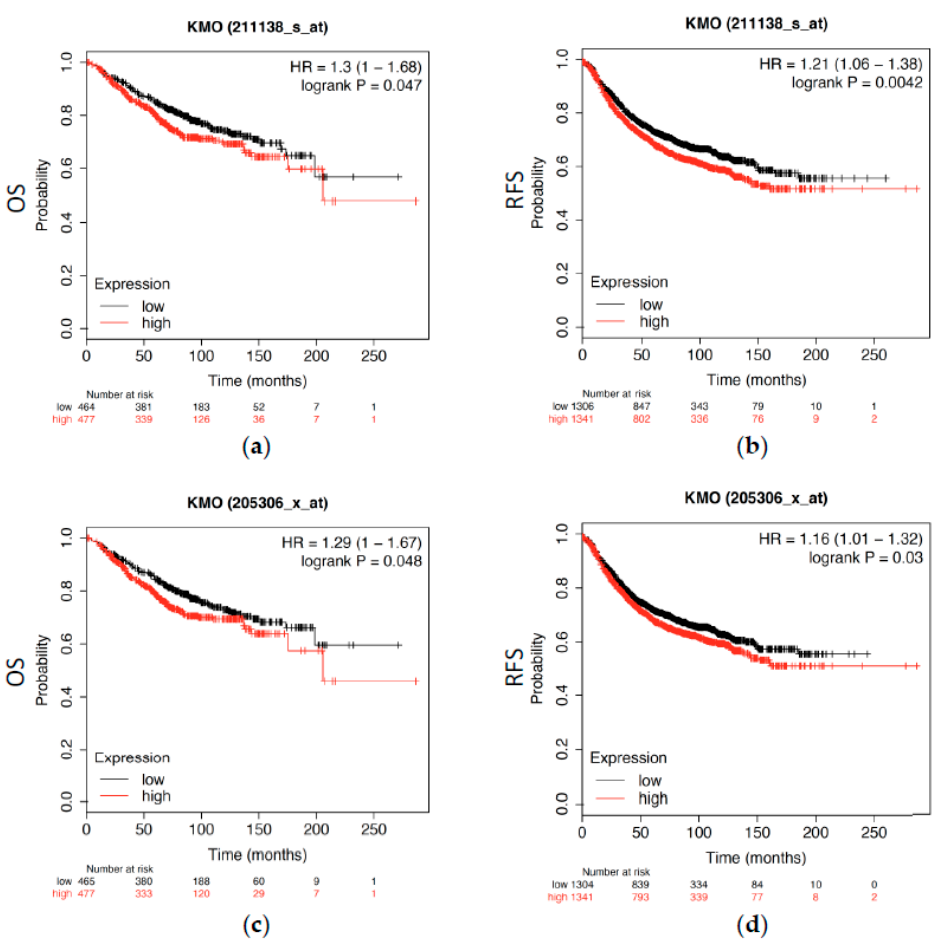
Figure 4. The prognostic value of KMO mRNA levels in breast cancer patients using the Kaplan– Meier plotter. Association between KMO ( a , b ) 211138_s_at and ( c , d ) 205306_x_at expression, and the OS and RFS rates in patients with breast cancer. (OS, overall survival; RFS, relapse-free survival).